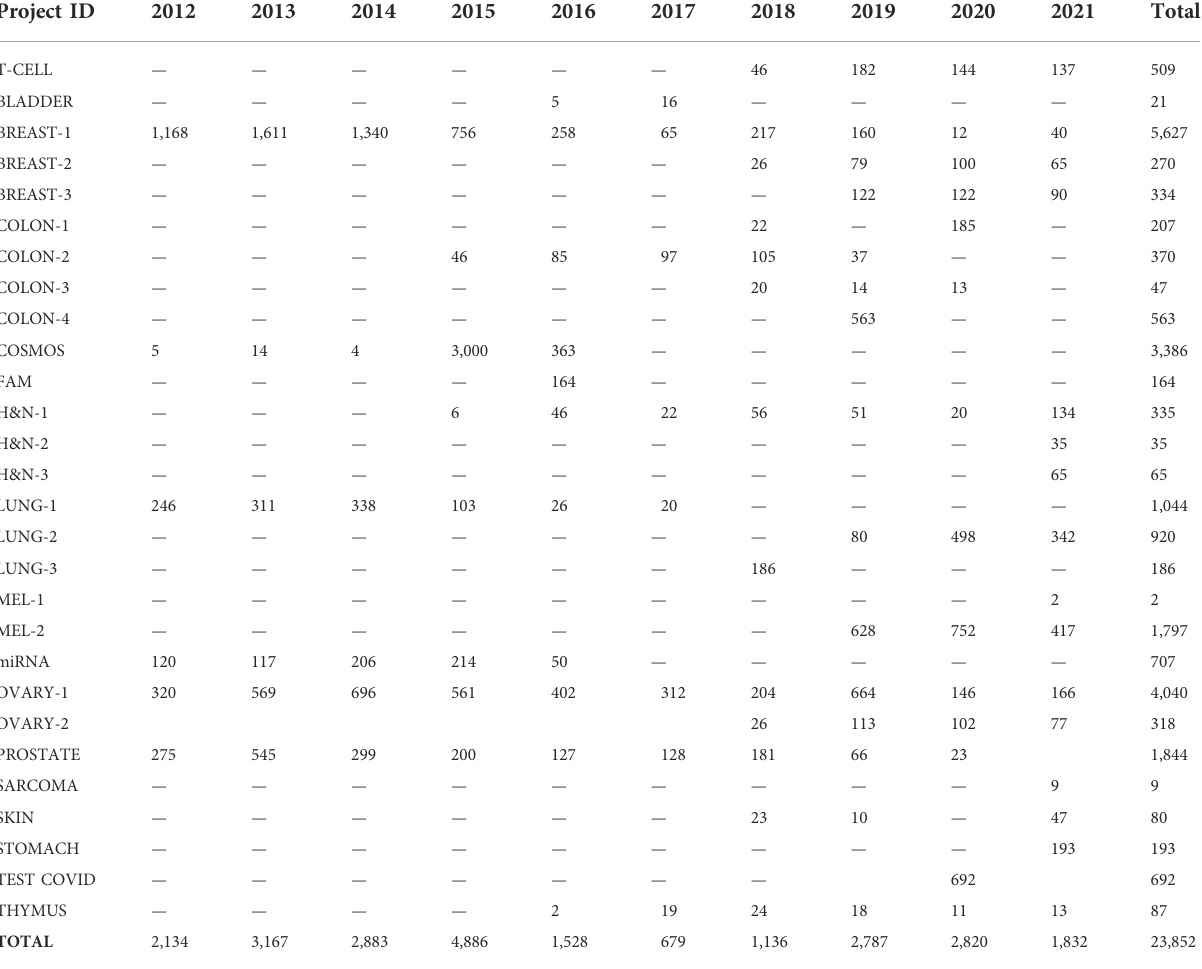
TABLE 4 Distribution of samples aliquots from the biobank of the European Institute of Oncology. Project ID